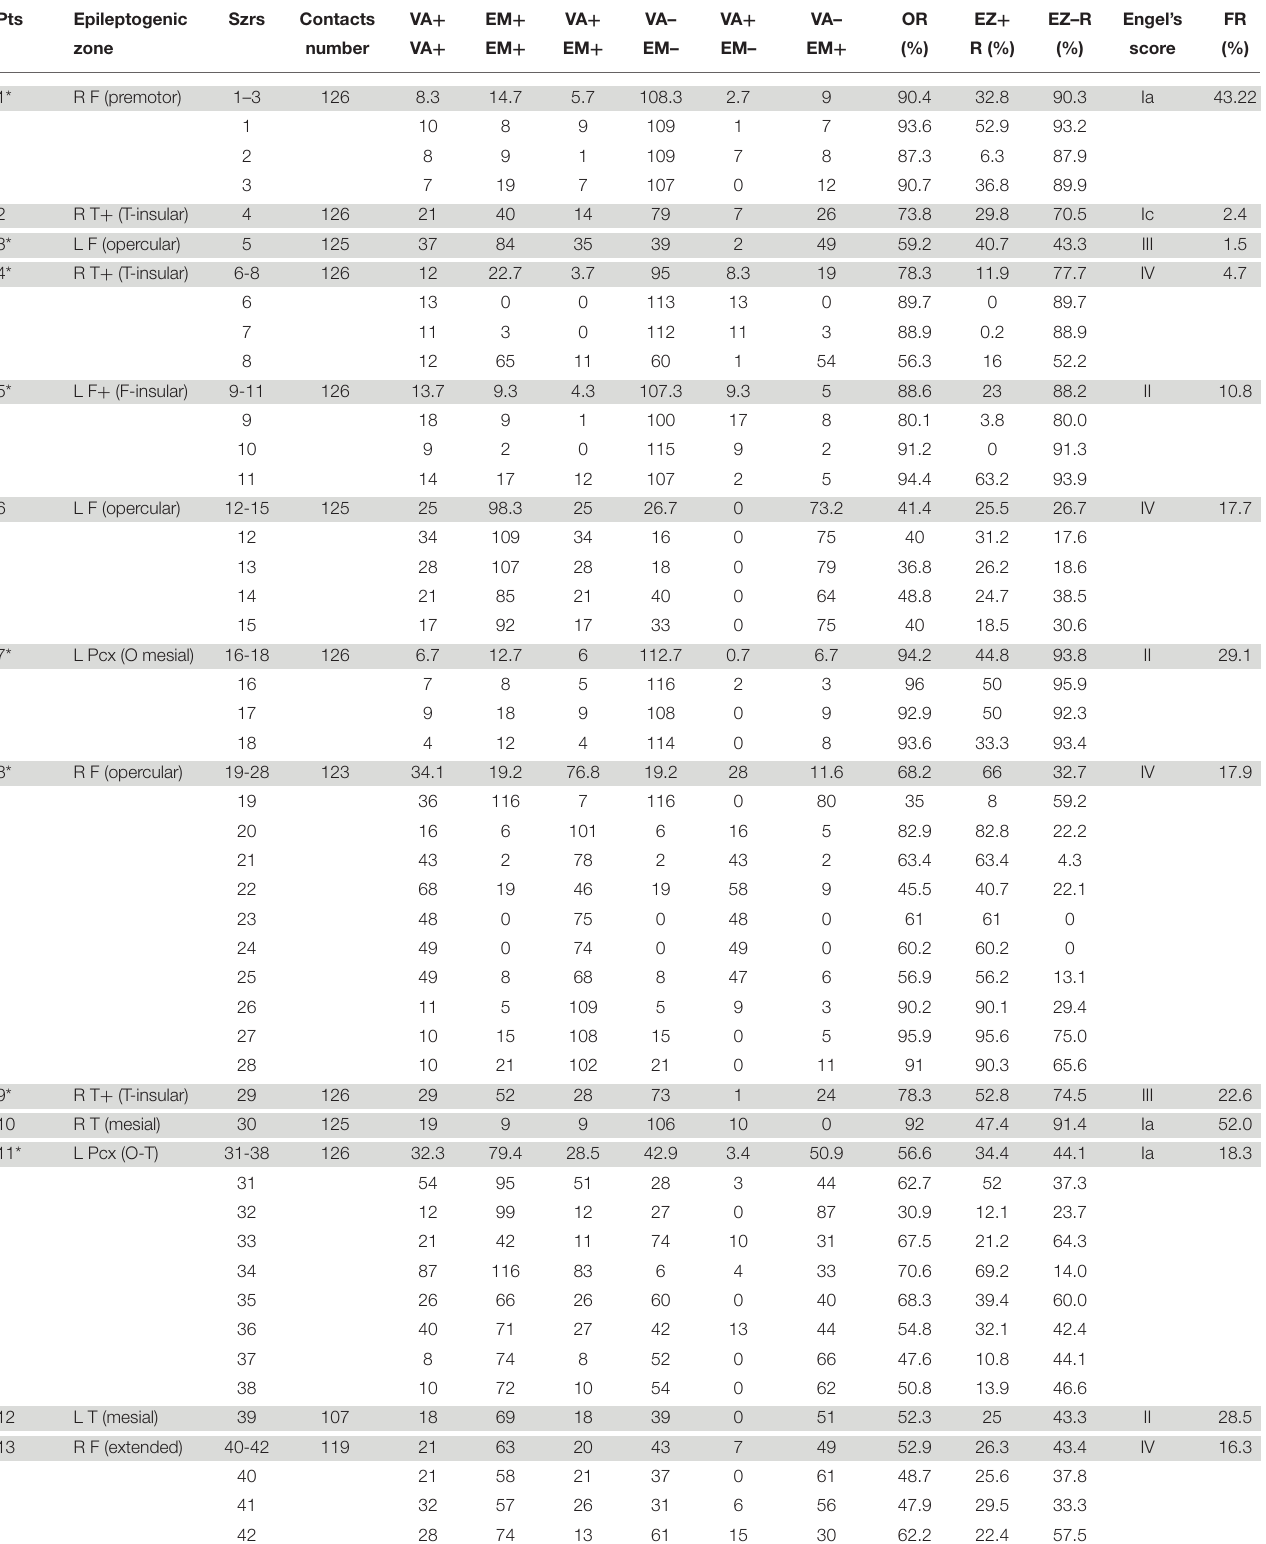
TABLE 1 | Comparison between visual and quantitative